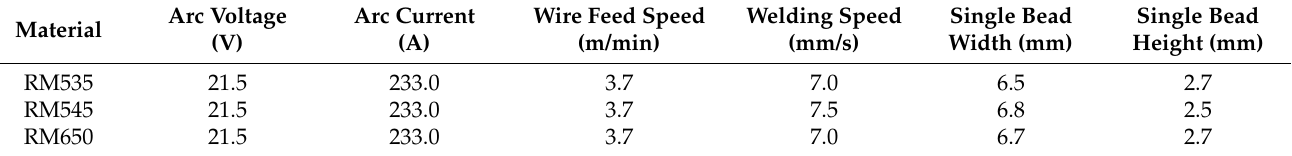
Table 4. Welding process parameters.